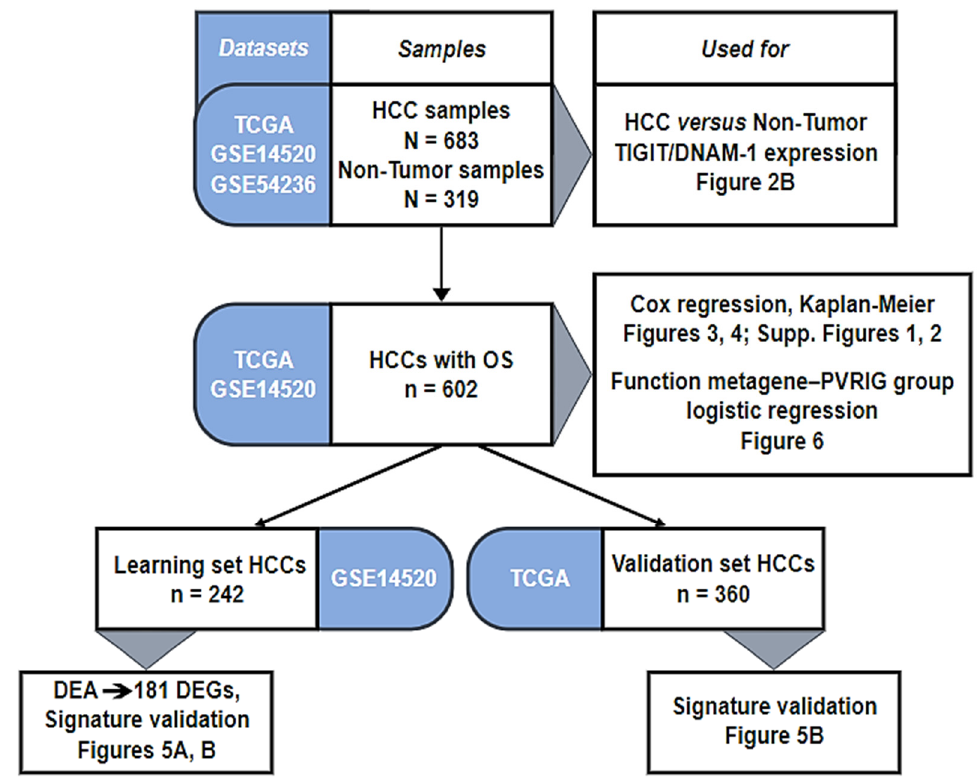
Figure 1. Analysis